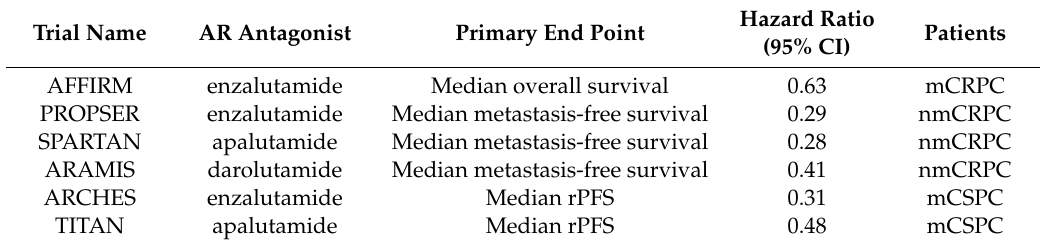
Table 10. Hazard Ratios for the primary end points in the phase III trials of three AR antagonists.